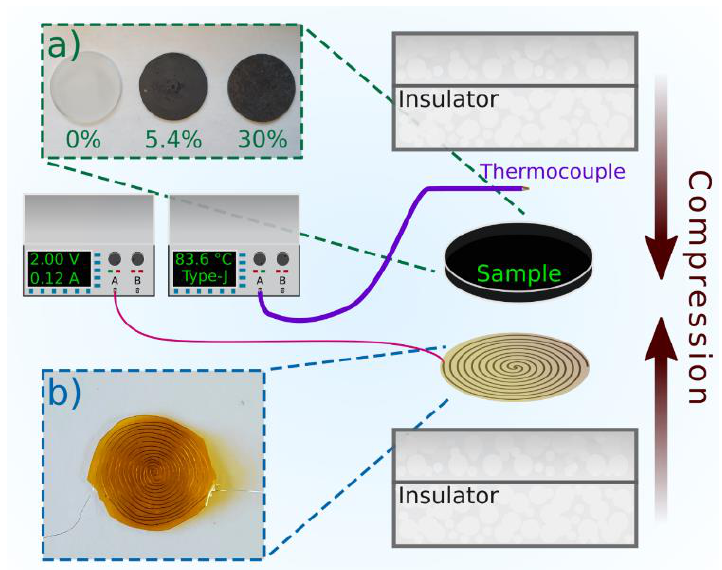
Figure 1. Simplified schematic of the temperature treatment experiment. A custom heating coil through which a current is passed is placed beneath the sample undergoing treatment. As a temperature feedback element, a Type-J thermocouple is used on the opposing surface of the sample to track its temperature. These are all then clamped under light compression between two thermal insulator materials. ( a ) Image of selected samples used in study. ( b ) Image of the custom heating element.